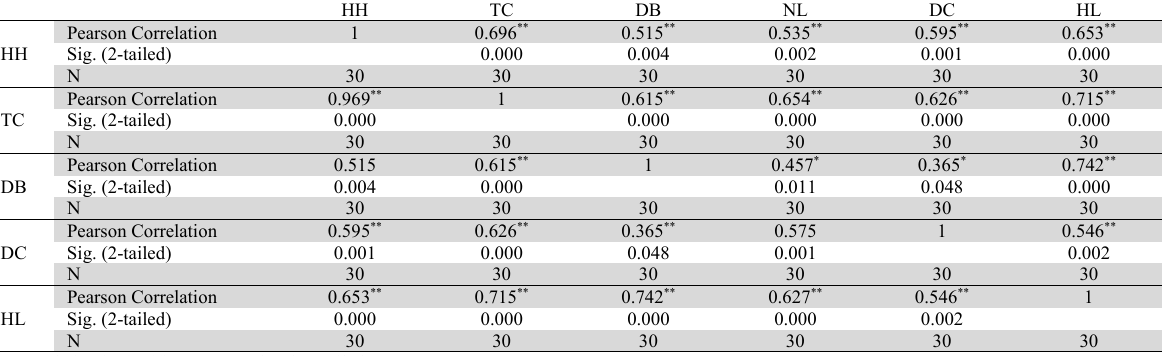
Correlation analysis between 5 independent variables and 1 dependent variable